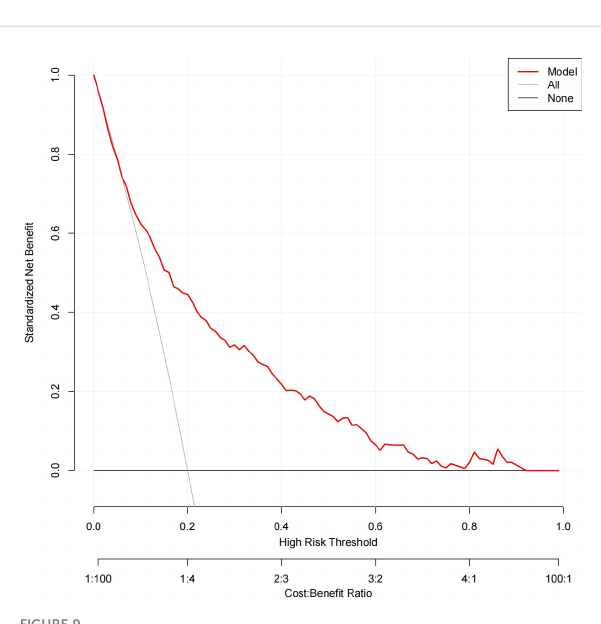
FIGURE 9 The DCA of the model using XG Boost ML. DCA, decision curve analysis; XG Boost ML, extreme gradient boosting (XG) machine learning